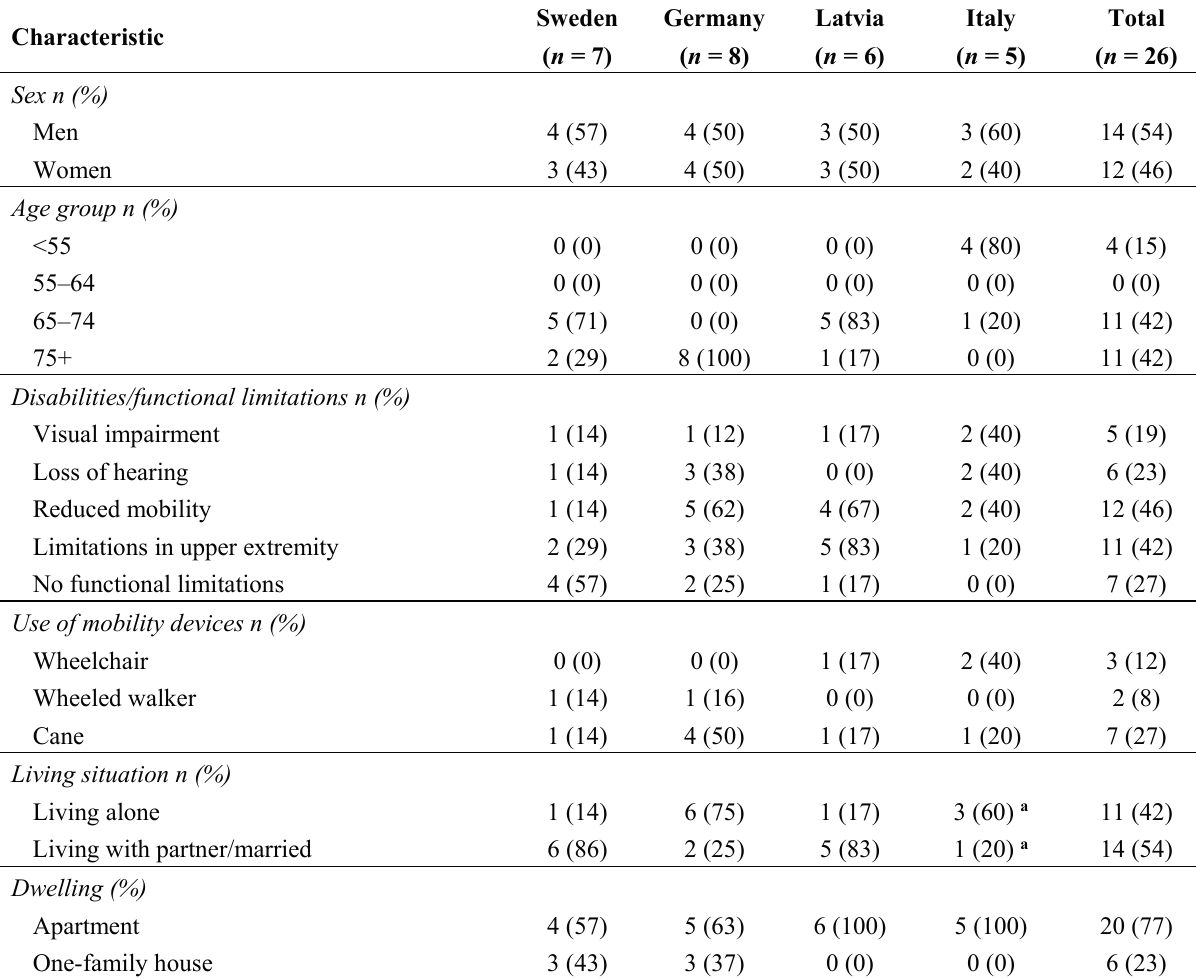
Table 1 . Characteristics of participants representing user perspective in the research circles ( n = 26). Characteristic